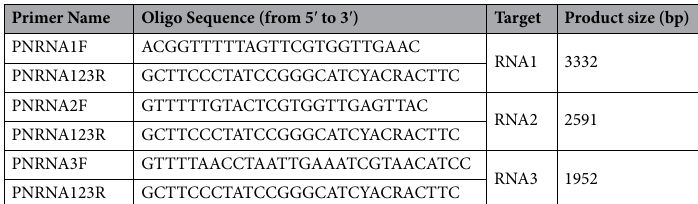
Table 1. Primers used for the amplification of the whole genome of PNRSV by one and two-step RT-PCR and mRT-PCR in this study.